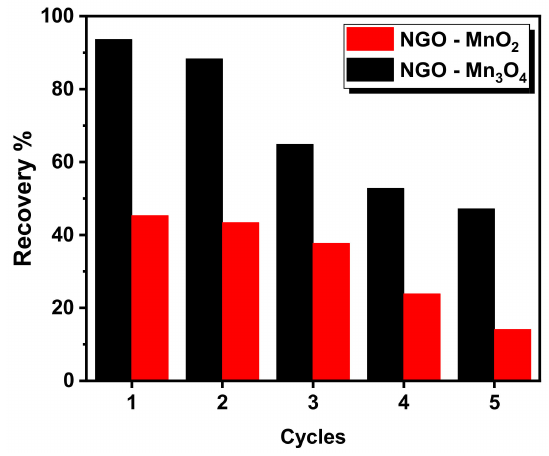
Figure 9. Recovery e ffi ciency of the NGO—MnO 2 and NGO—Mn 3 O 4 after 5 cycles of adsorption— desorption (Co = 100 mg / L, pH = 3, m = 0.01 g, V = 0.02 L).